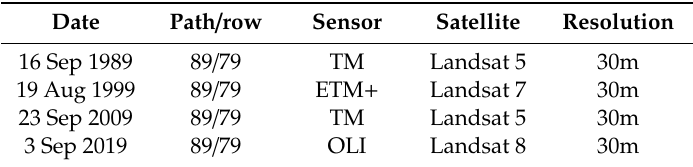
Table 1. Characteristics of Landsat data.